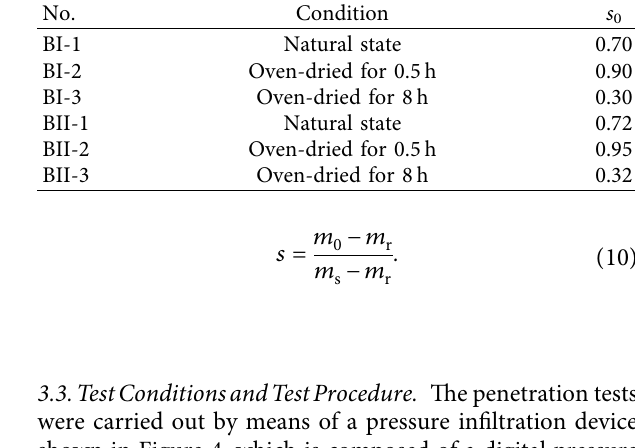
Figure 3: Sealing of the cracks on the specimen bottom.